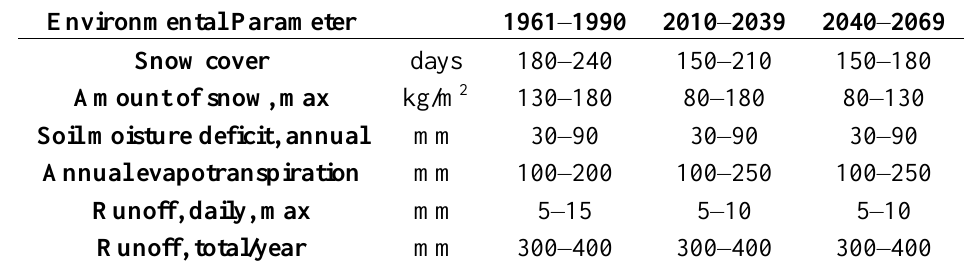
Table 1. Expected changes in hydropower-specific environmental parameters in future climate compared to the years 1961–1990. The data is collected from the climate statistics produced by Finnish Meteorological Institute